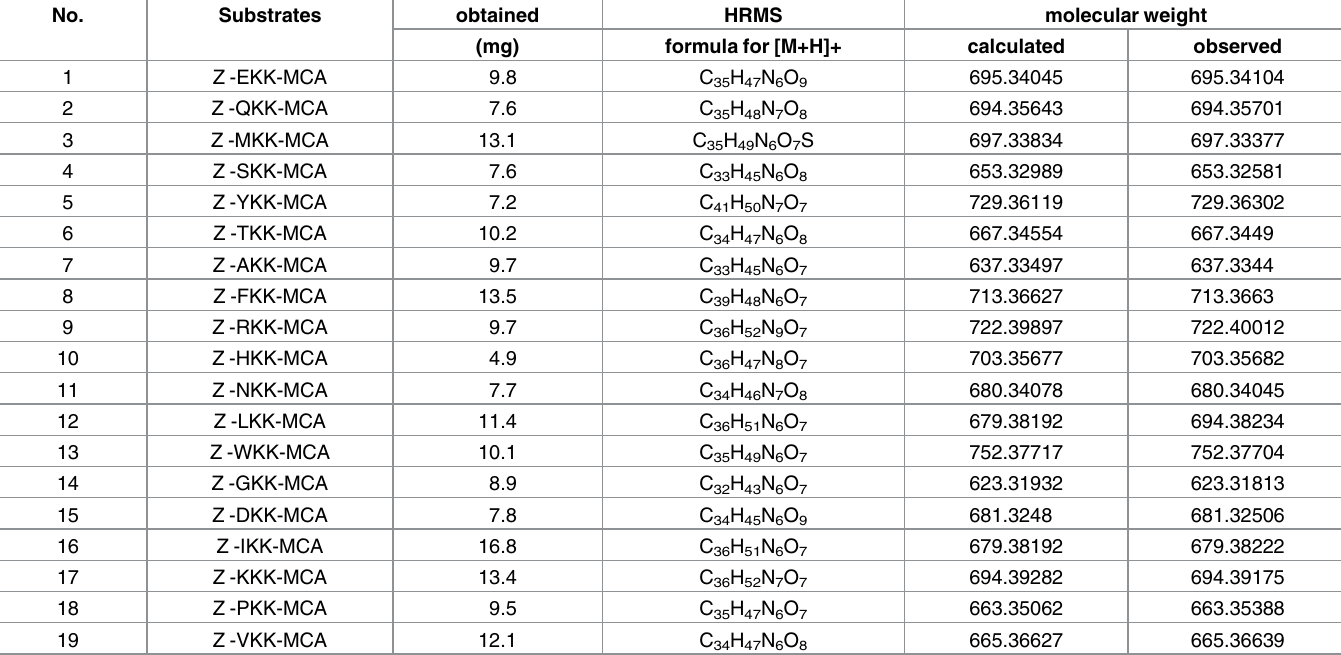
Table 1. High-resolution mass spectrometry data and the yield for synthetic substrates.